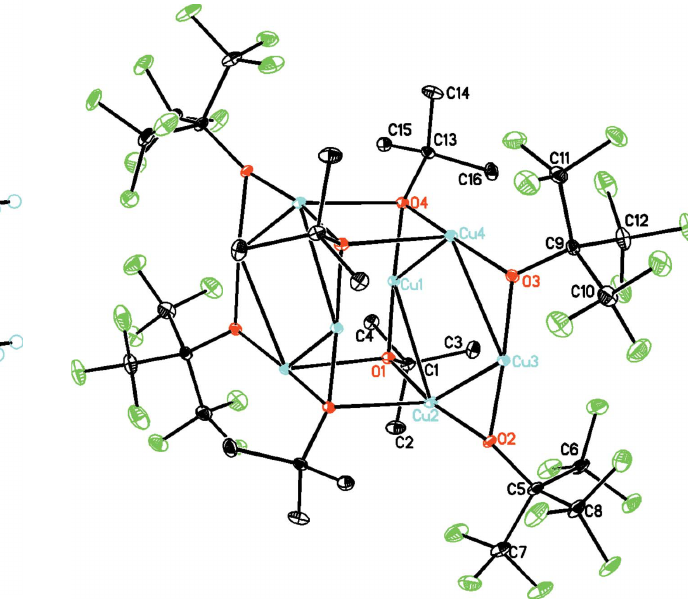
Figure 2 Diagram for 1 showing the association of two units into centrosymmetric dimers by weak Cu—O bonds. Hydrogen atoms omitted for clarity. Atomic displacement parameters are at the 30% level.